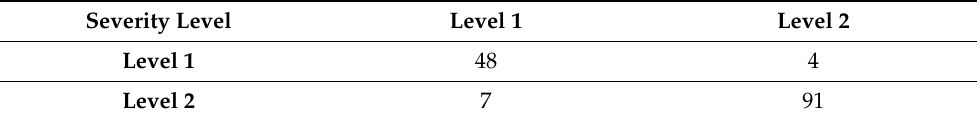
Table 5. Confusion Matrix of COVID-Net CXR-S.